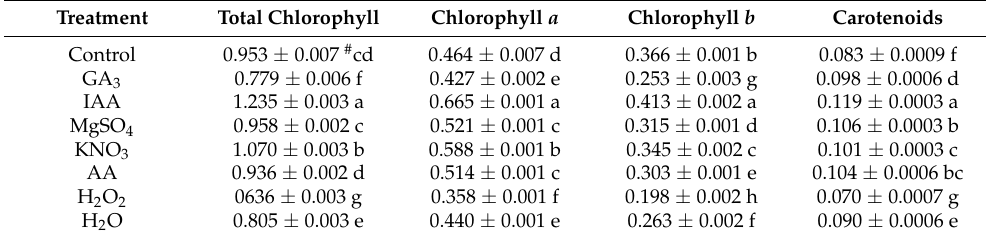
# The values represent the means of six replicates ± standard error. Different letters indicate significant differences ( p ≤ 0.05) between treatments according to Tukey’s